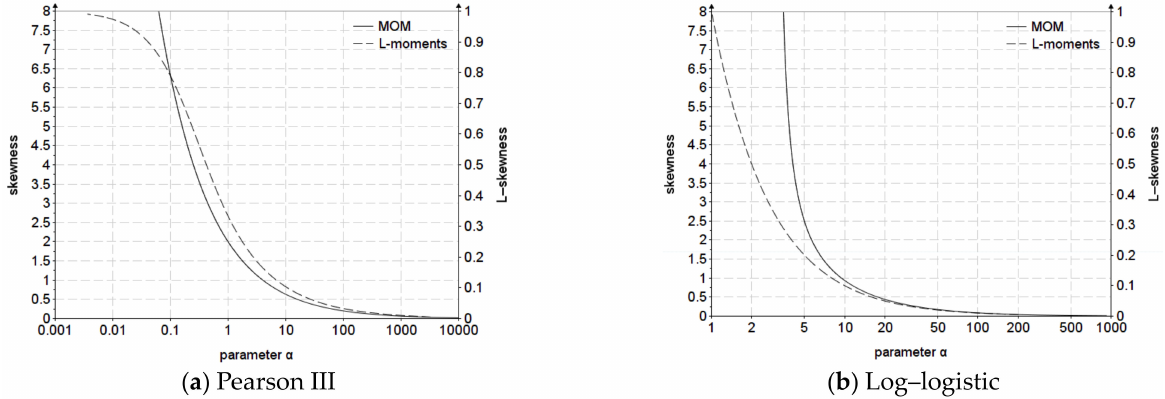
Figure 5. The variation of parameter α